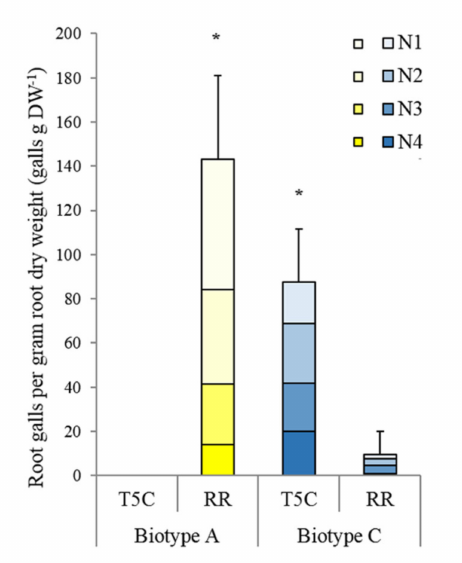
Figure 1. Average number of root galls (galls gDW − 1 ) formed by grape phylloxera biotype A and C on roots of potted V. vinifera L. Riesling (RR) and the rootstock Teleki 5C ( V. berlandieri × V. riparia ) (T5C). Galls were categorized by size: N1 < 0.3 cm, N2 0.3 cm–0.6 cm, N3 > 0.6 cm, and N4 = inseparable galls. Error bars represented standard deviations of the sum of galls (N1–N4). Asterisks illustrated significant di ff erences obtained by Mann–Whitney U testing with p < 0.05 comparing the sum of galls (N1–N4) produced by each biotype on the host versus the